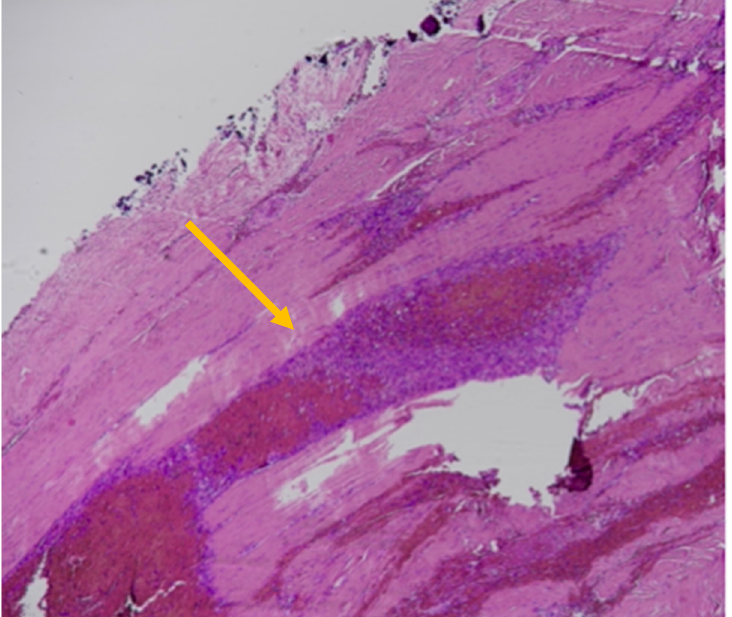
Figure 4. Histological findings of subacute SDHs > 5 days old: thin layer of fibroblasts between the dura and the clot (yellow arrow); granulation tissue; siderophages; breakdown of erythrocytes (yellow arrow; Hematoxylin & Eosin).